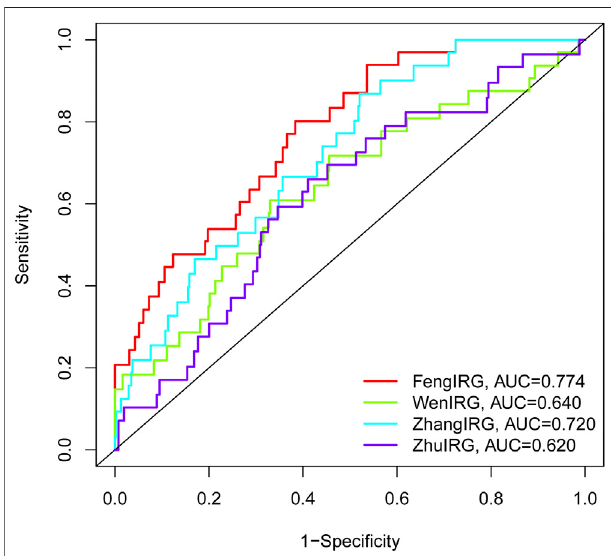
FIGURE7| The AUCofOSfortheIRGSig and threepreviouslyreported IRGs signatures at 1 year.